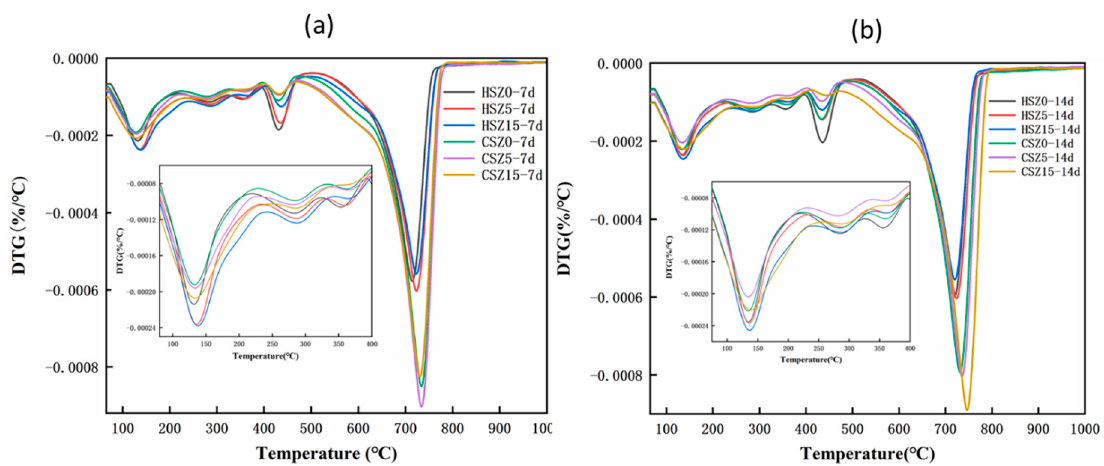
Figure 7. Di ff erential thermogravimetry (DTG) curves of SZ specimens after “H” or “C”. (H: hydration at di ff erent times; C: hydration at di ff erent times and subsequent 2 h carbonation). ( a ) DTG curves of HSZ-7d and CSZ-7d; ( b ) DTG curves of HSZ-14d and CSZ-14d.